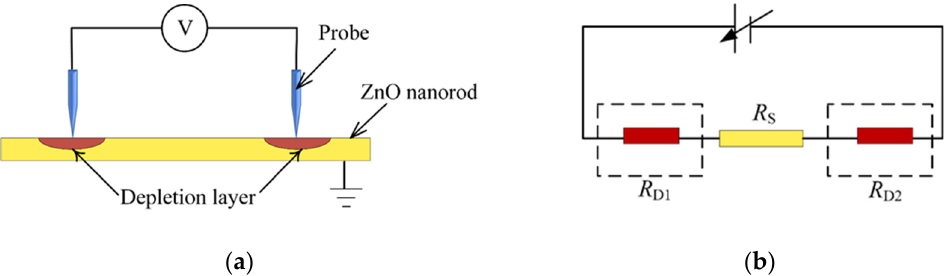
Figure 1. Equivalent electric circuit of metal-semiconductor-metal structure. ( a ) Probe is marked in blue. When semiconductor ZnO nanorod come into contact with probe electrode, a barrier is formed at the contact point which is called depletion layer. ( b ) Three resistors in the circuit. R D1 and R D2 are resistance of the depletion layer, R s is resistance of the ZnO nanorod.